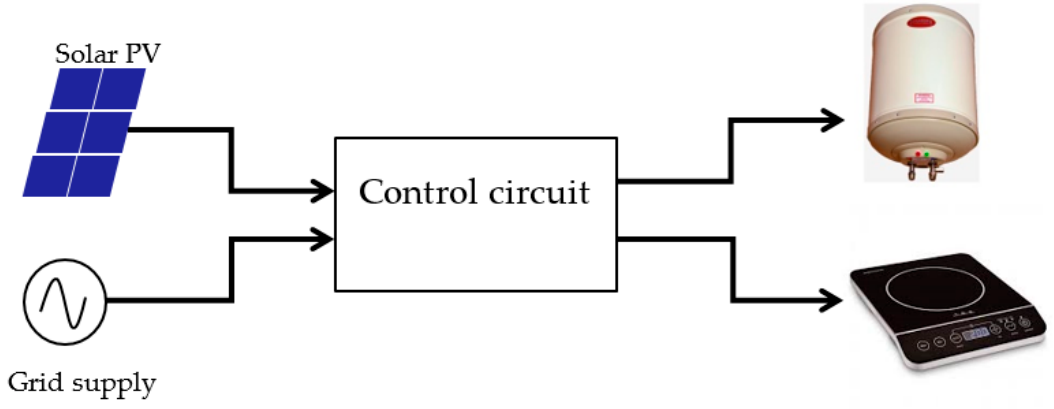
Figure 1. The block diagram for the proposed cooking system.